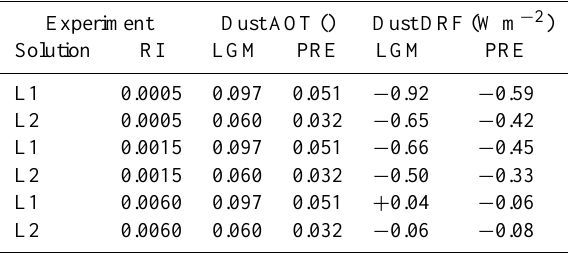
Table 3. Global mean dust AOT and dust DRF at TOA from six simulations using solutions L1 and L2 and low, medium and high imaginary refractive index (RI) calculated at 21ka (LGM) and 0ka (PRE). Experiment